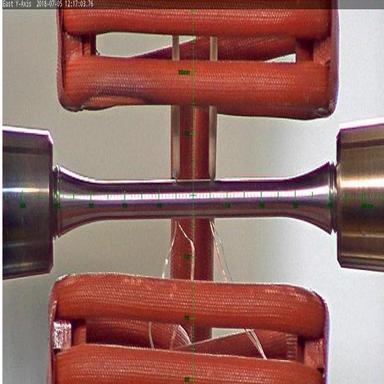
Image of sample with extensometer on top.